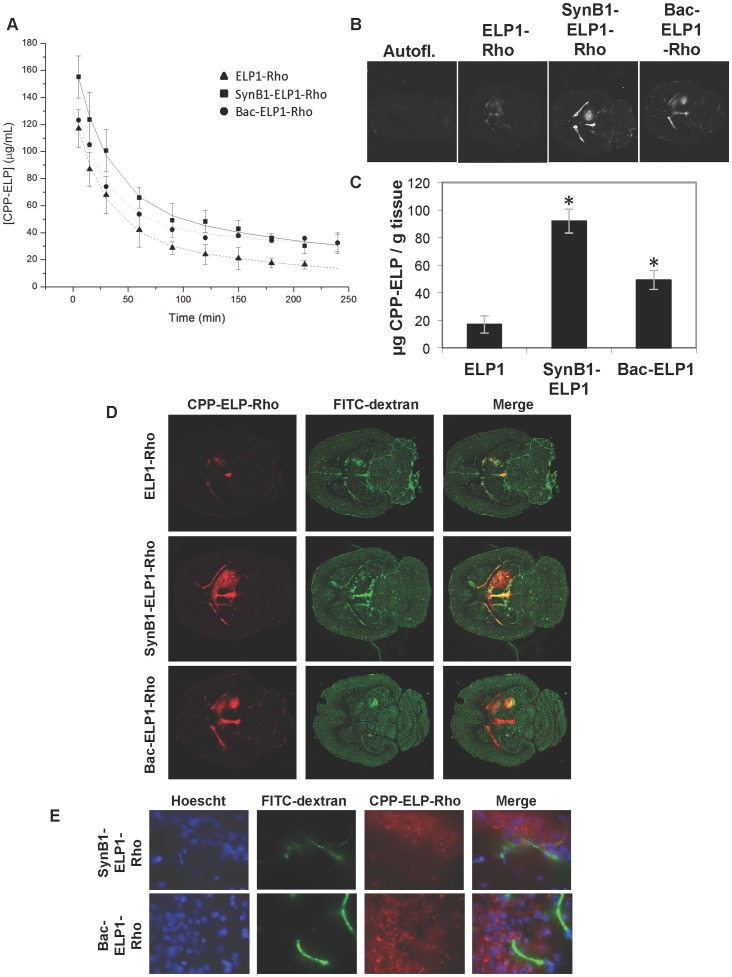
Plasma Clearance and Tumor Uptake of CPP-ELPs. A.Plasma levels with time following IV injection of ELP1-Rho, SynB1-ELP1-Rho, or Bac-ELP1-Rho. Data represent the mean ± s.d. of 6 animals per group. B. Representative images of brain sections 4 h after IV injection of rhodamine-labeled polypeptides. C. Tumor levels 4 h after IV administration of rhodamine-labeled ELP or CPP-ELPs. Bars, s.e. *, Tumor levels are significantly enhanced (p<0.01, one way ANOVA with post hoc Bonferroni, n = 6 rats/group). D. Distribution of rhodamine-labeled polypeptides in tumor and normal brain relative to perfused vasculature. Rhodamine fluorescence was used to follow the localization of the polypeptide within the tumor (left panel), and the perfused vasculature was marked by infusion of high molecular weight dextran 1 min prior to euthanasia (middle panel). E. Microscopic images of tumor sections were collected after staining cell nuclei with Hoechst 33342 using a 60× magnification objective.